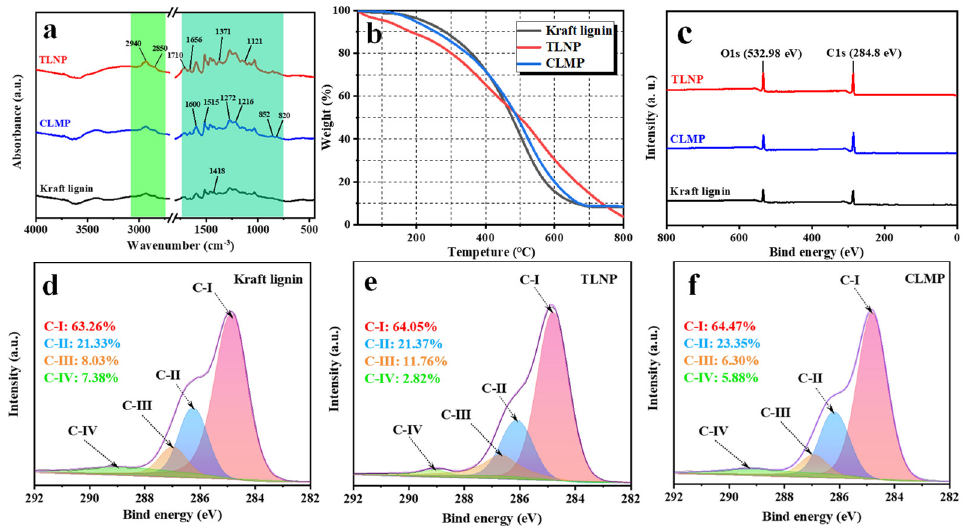
Figure 4. FTIR spectral profiles ( a ), TG ( b ), XPS ( c ), and C 1s spectra ( d ) kraft lignin, ( e ) TLNP, ( f ) CLMP recorded for kraft lignin, TLNP and CLMP.